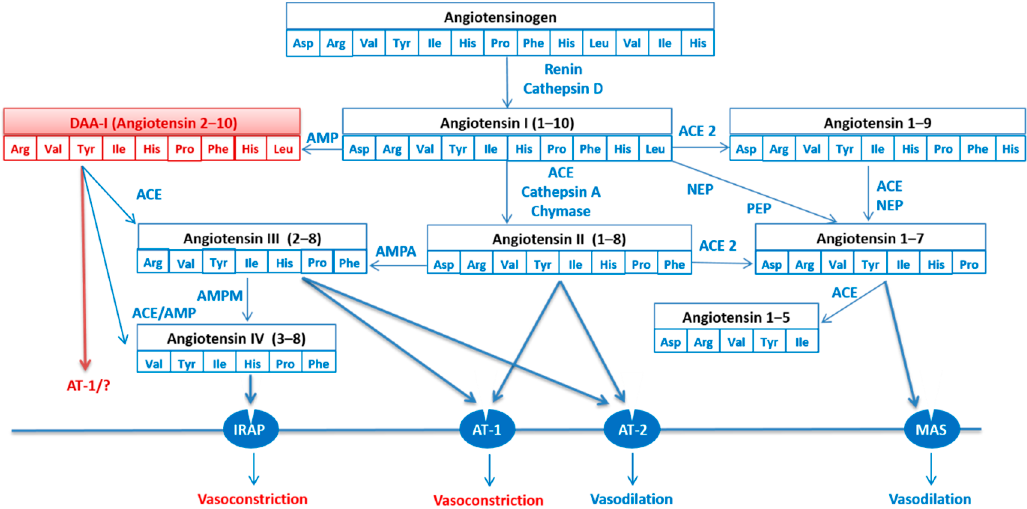
Figure 1. The renin–angiotensin system (RAS). Renin increases angiotensin I (Ang I) formation from angiotensinogen and ACE/chymase induces angiotensin II (Ang II) formation from Ang I. Ang I is converted to angiotensin (1–7) and angiotensin (2–10) or DAA-1. Angiotensin II and Angiotensin III stimulate AT-1 and AT-2 receptors. Angiotensin 1–7 bind to the MAS receptor. The ACE2-Ang-(1–7)-Mas axis is now considered a putative counter-regulatory system to the ACE-AngII-AT1R axis. Angiotensin IV stimulates AT-4 receptors or insulin-regulated aminopeptidase (IRAP). Effects mediated via AT-2 and MAS receptors generally oppose those of AT-1. Abbreviations: ACE: angioten-